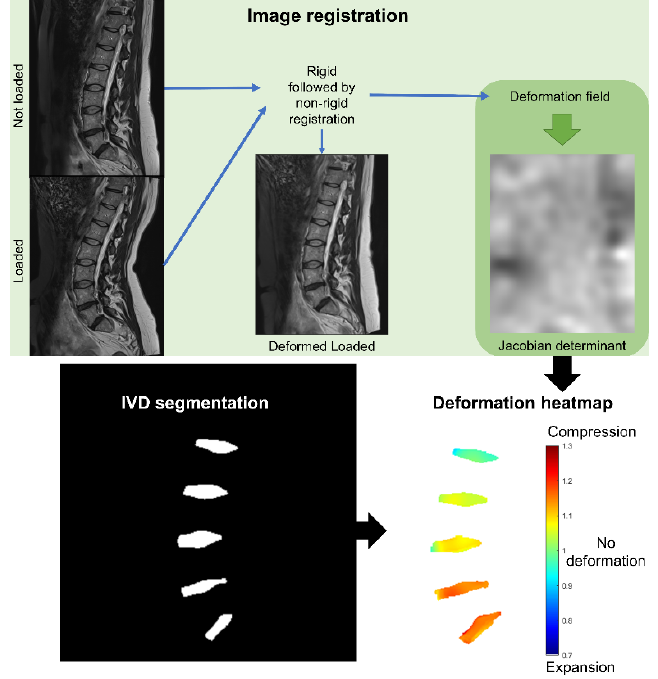
Figure 2. Schematic illustration of the method to measure the intradiscal deformation. The T2- weighted image of the loaded lumbar spine was rigidly and then non-rigidly transformed to the space of the MR image of the unloaded spine. The deformation field, retrieved from the registration, was used to calculate the Jacobian determinant. The Jacobian determinant in the IVDs, which represented the intradiscal deformation, was displayed in detail as heatmaps, where the IVDs were selected automatically using automatic segmentation of the IVDs.